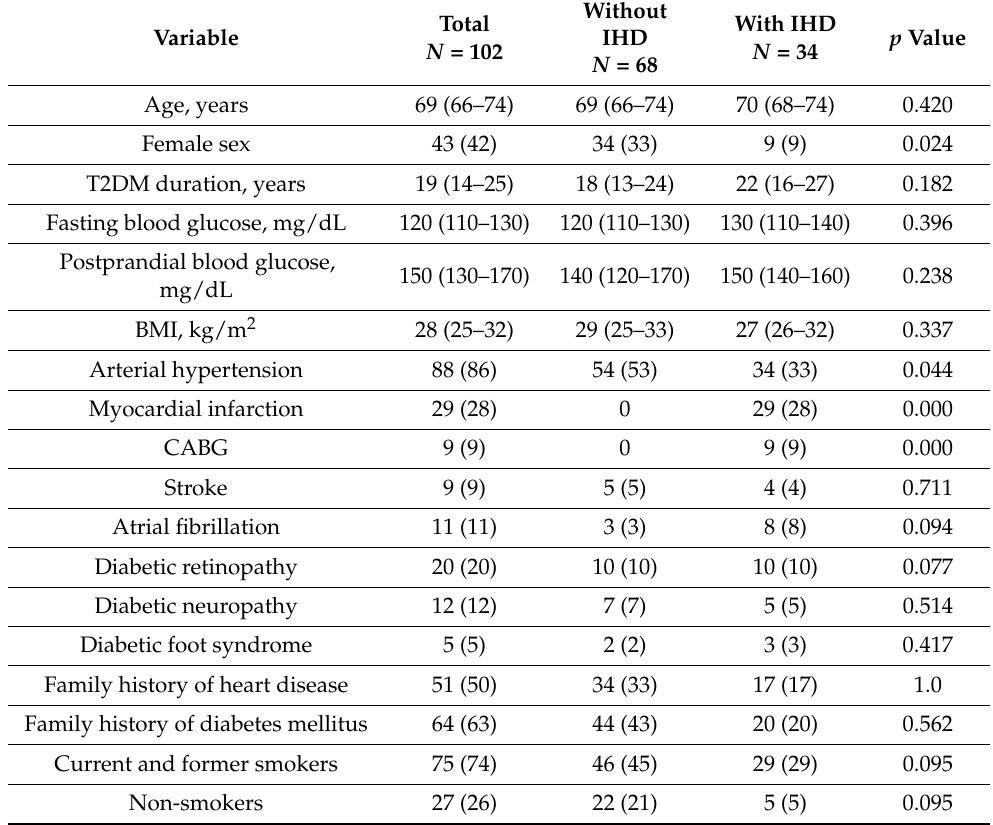
Table 1. Baseline